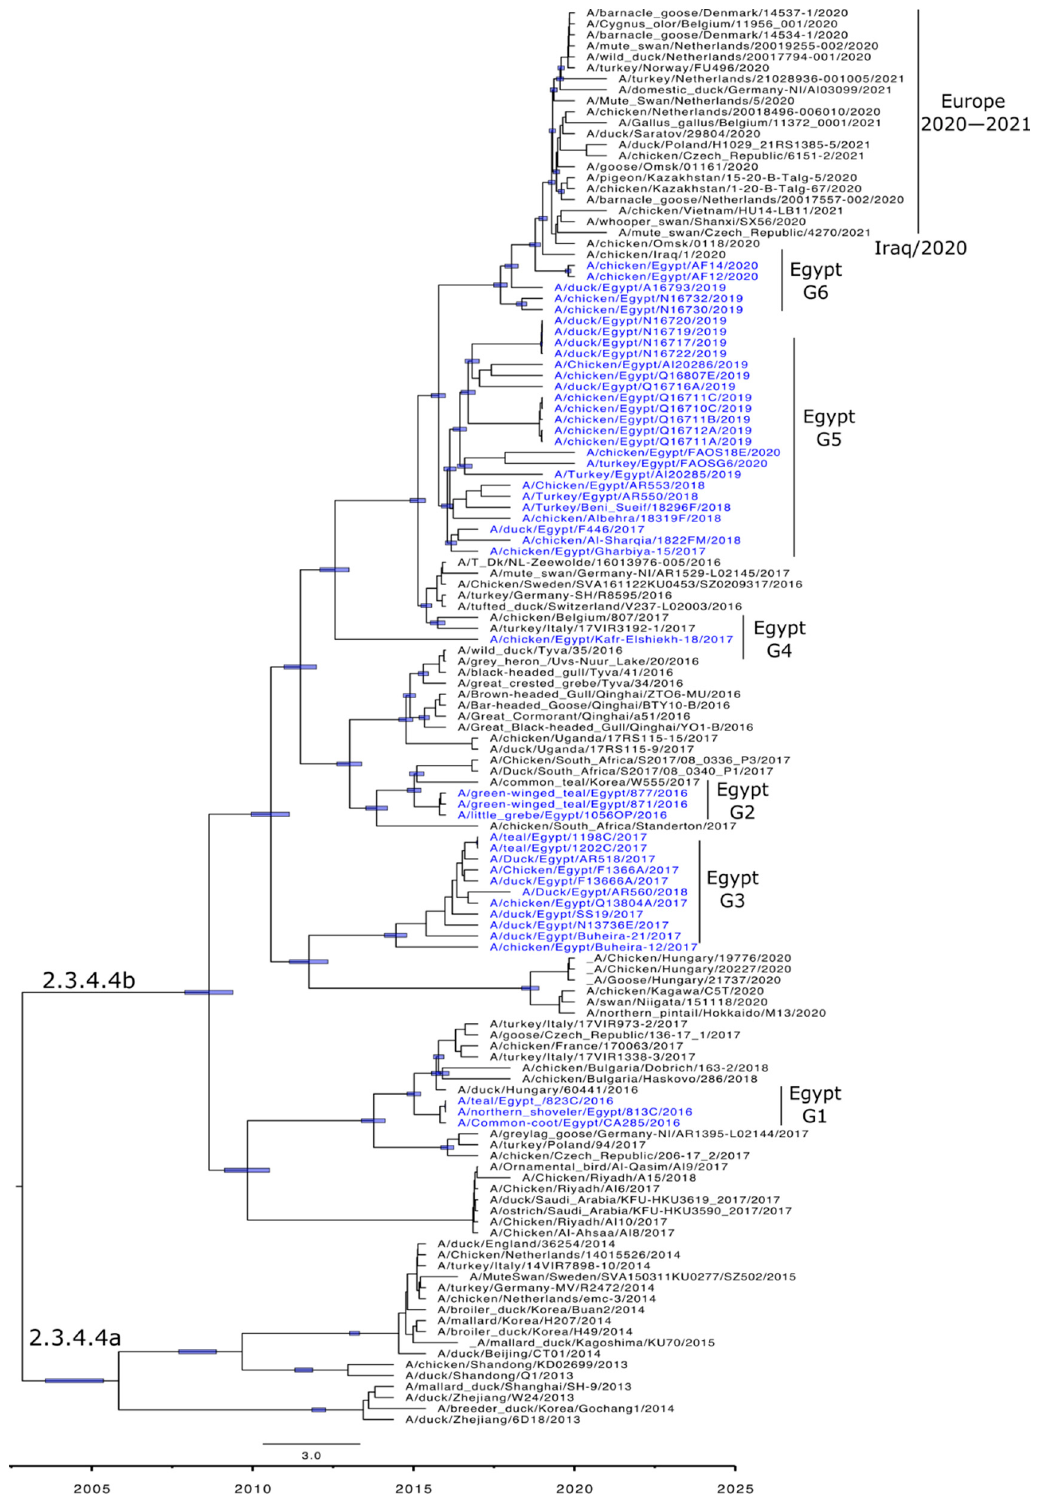
Figure 4. Time-scaled Bayesian maximum clade credibility tree of the concatenated whole genome of HPAI H5N8 viruses from Egypt (blue) and representative H5N8 viruses. Node bars represent 95% Bayesian credible intervals for estimates of common ancestry and are shown on the main nodes. Genotyping of the Egyptian viruses is based on sequence similarity and years of